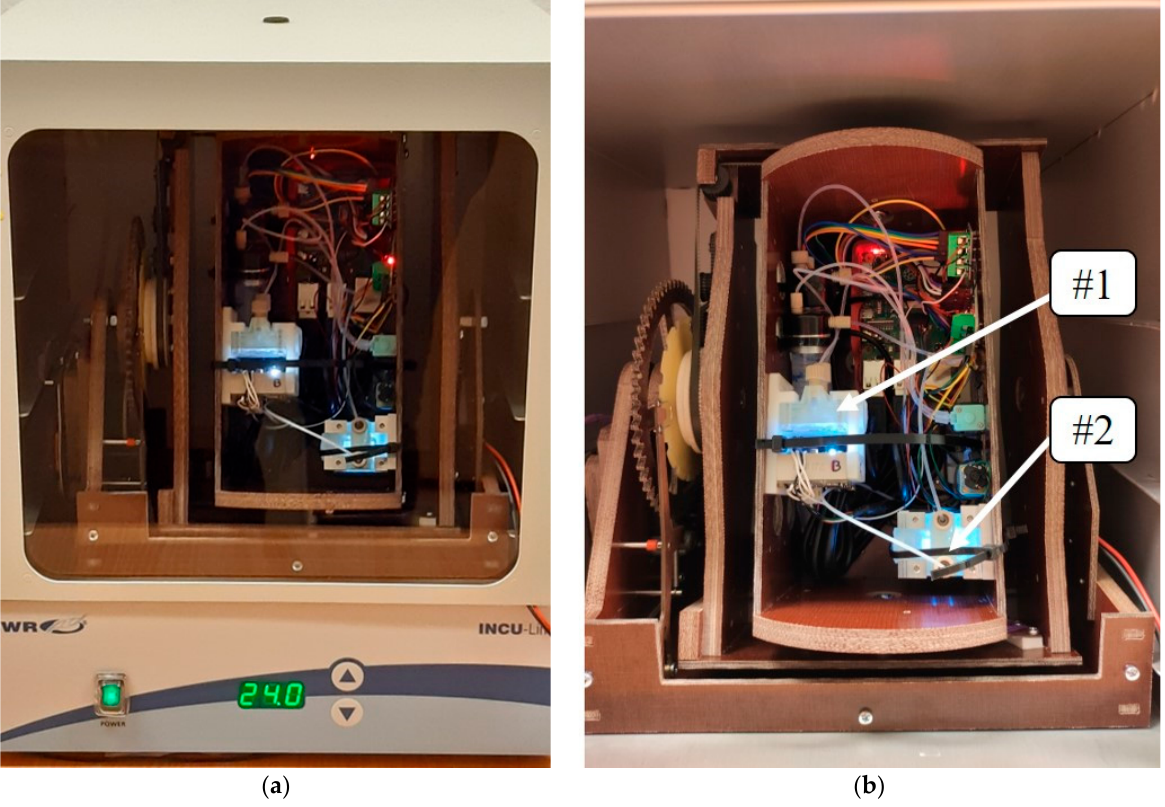
Figure 4. RPM machine with payload: ( a ) during microgravity experiments inside the incubator, and ( b ) two independent micropot modules highlighted on the right